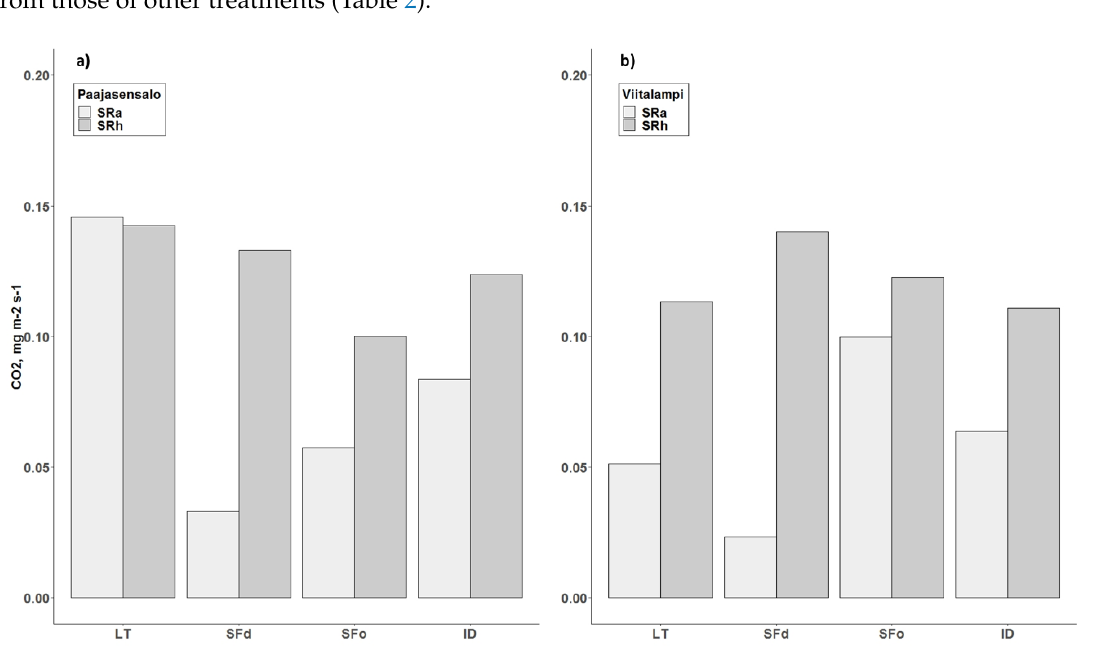
Figure 4. Means of autotrophic (SR a ) and heterotrophic (SR h ) soil surface respiration, based on the measurements in May–Sept 2017, of each treatment (one weekly mean value per treatment) in plots established in 2015 for ( a ) Paajasensalo and ( b ) Viitalampi. LT = living trees, SF d = storm dead tree detritus, SF o = storm open-vegetated, ID = trees killed by I. typographus . The proportion of SR a relative to SR tot at Paajasensalo was 51% for LT, 20% for SF d , 36% for SF o , and 40% for ID treatment. The corresponding proportions at Viitalampi were 31% for LT, 14% for SF d , 45% for SF o , and 36% for ID. This resulted in a shift in SR tot towards SR h at disturbed plots